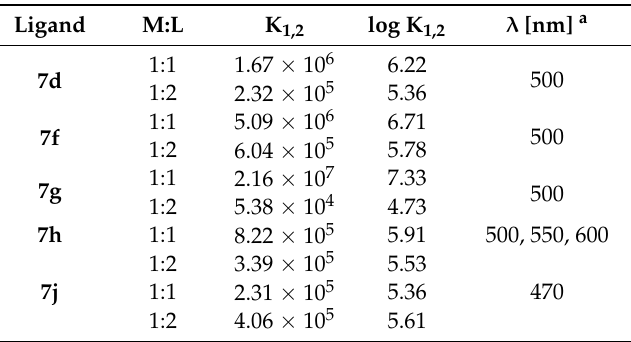
Figure 3. ( a ) Absorbance vs. [Fe 3+ ]/[ligand] mole-ratio plot for all Fe 3+ - 7d , f – h , j complexes; ( b ) Absorbance vs. [Fe 3+ ]/[ligand] mole-ratio plot for Fe 3+ - 7d complexation in aq. MeOH 85% (red asterisks—experimental data, black line—nonlinear curve-fitting according to eqn.3 from Materials and Methods Section). Table 1. Stoichiometry and K f values for Fe 3+ - 7d, Fe 3+ - 7f, Fe 3+ - 7g, Fe 3+ - 7h and Fe 3+ - 7j complexes determined by the mole-ratio method.